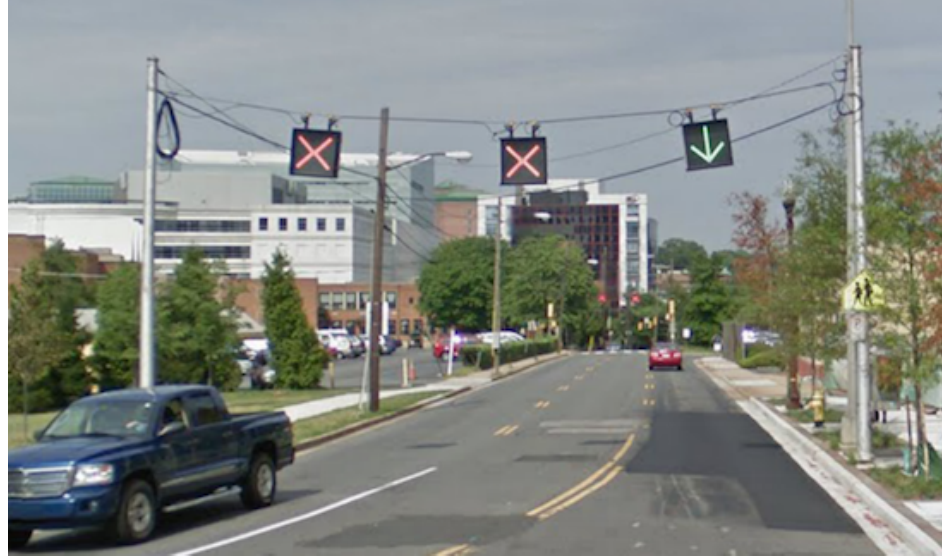
Figure 2. Overhead digital signals from Washington Blvd., Arlington, VA, USA